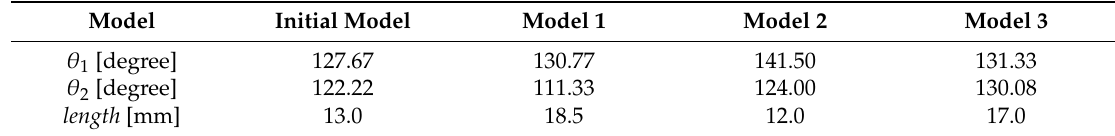
Table 5. Variables of initial and optimal models. Table 6. Performance comparison of initial and optimal models.